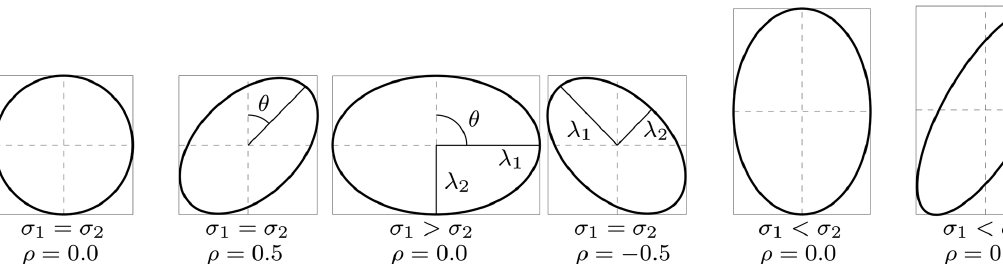
The Cryosphere, 16, 2285–2300, 2022